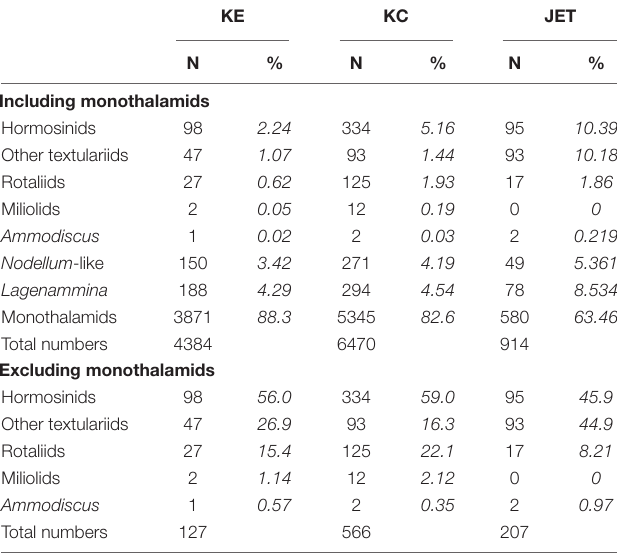
TABLE 6 | Proportions of major foraminiferal groupings in > 32- µ m fraction of subsamples (0-1 cm layer) from Kaplan East (KE), Kaplan Central (KC) and JET sites.